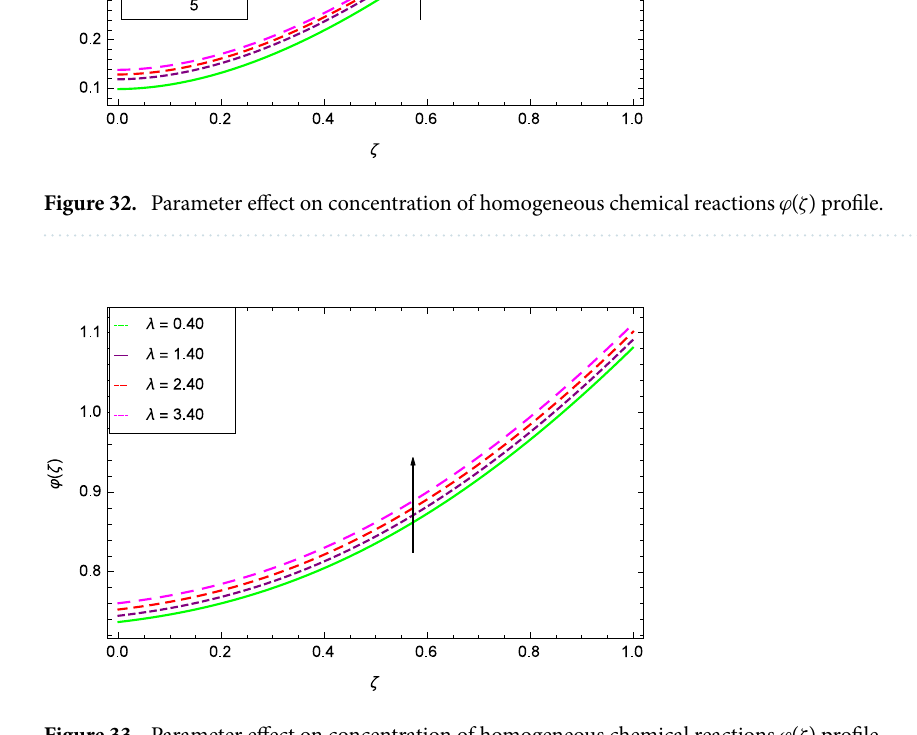
Figure 33. Parameter effect on concentration of homogeneous chemical reactions ϕ ( ζ )